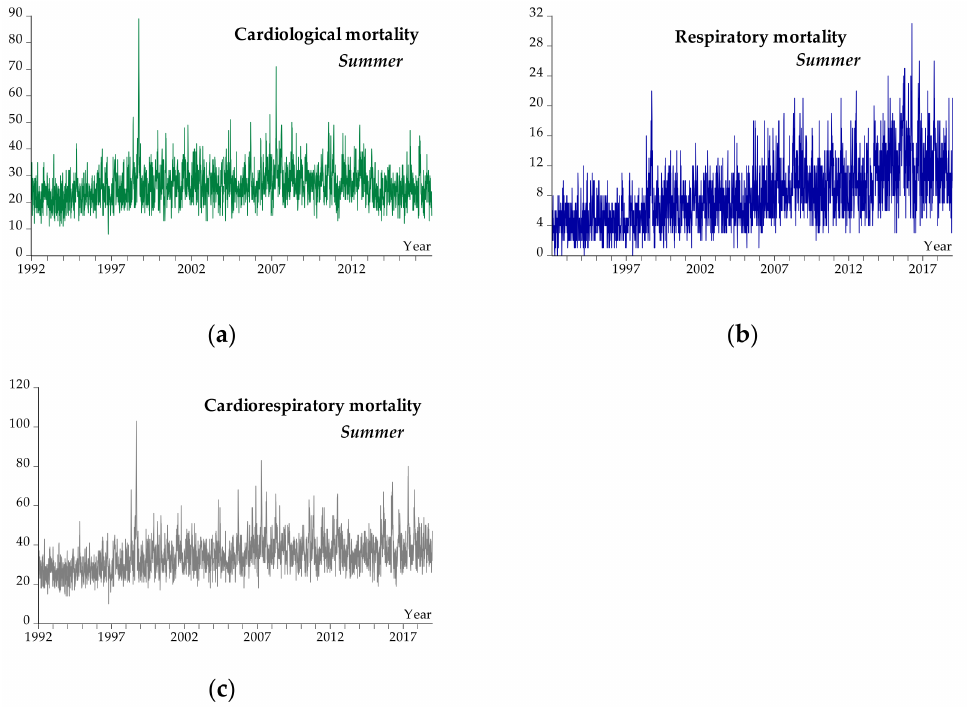
Figure 1. Graphs of mortality for Attica: ( a ) Graph of cardiological mortality during summer months; ( b ) graph of respiratory mortality during summer months; ( c ) graph of cardiorespiratory mortality during summer months.